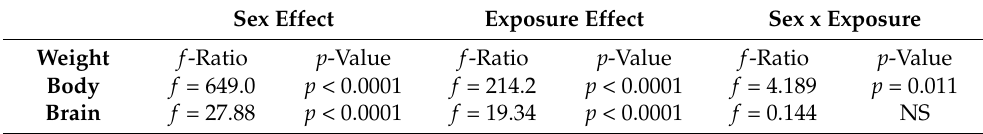
Table 1. Effects of Sex and Exposures (Ethanol + Dietary Protein) on Body and Brain